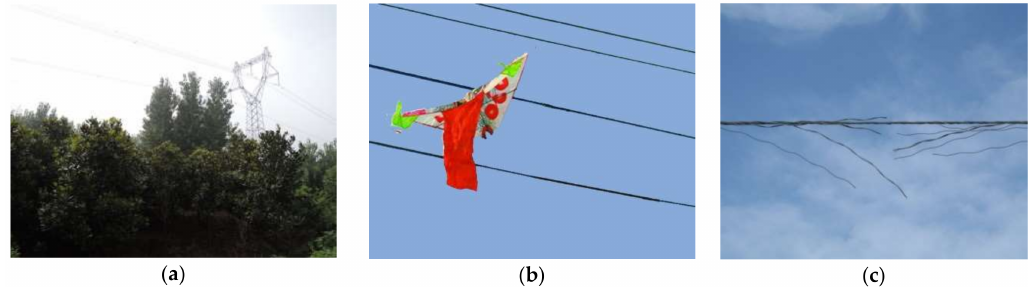
Figure 1. The hidden troubles in safe operation of power line: ( a ) Vegetation encroachment; ( b ) Attachment; ( c ) Broken